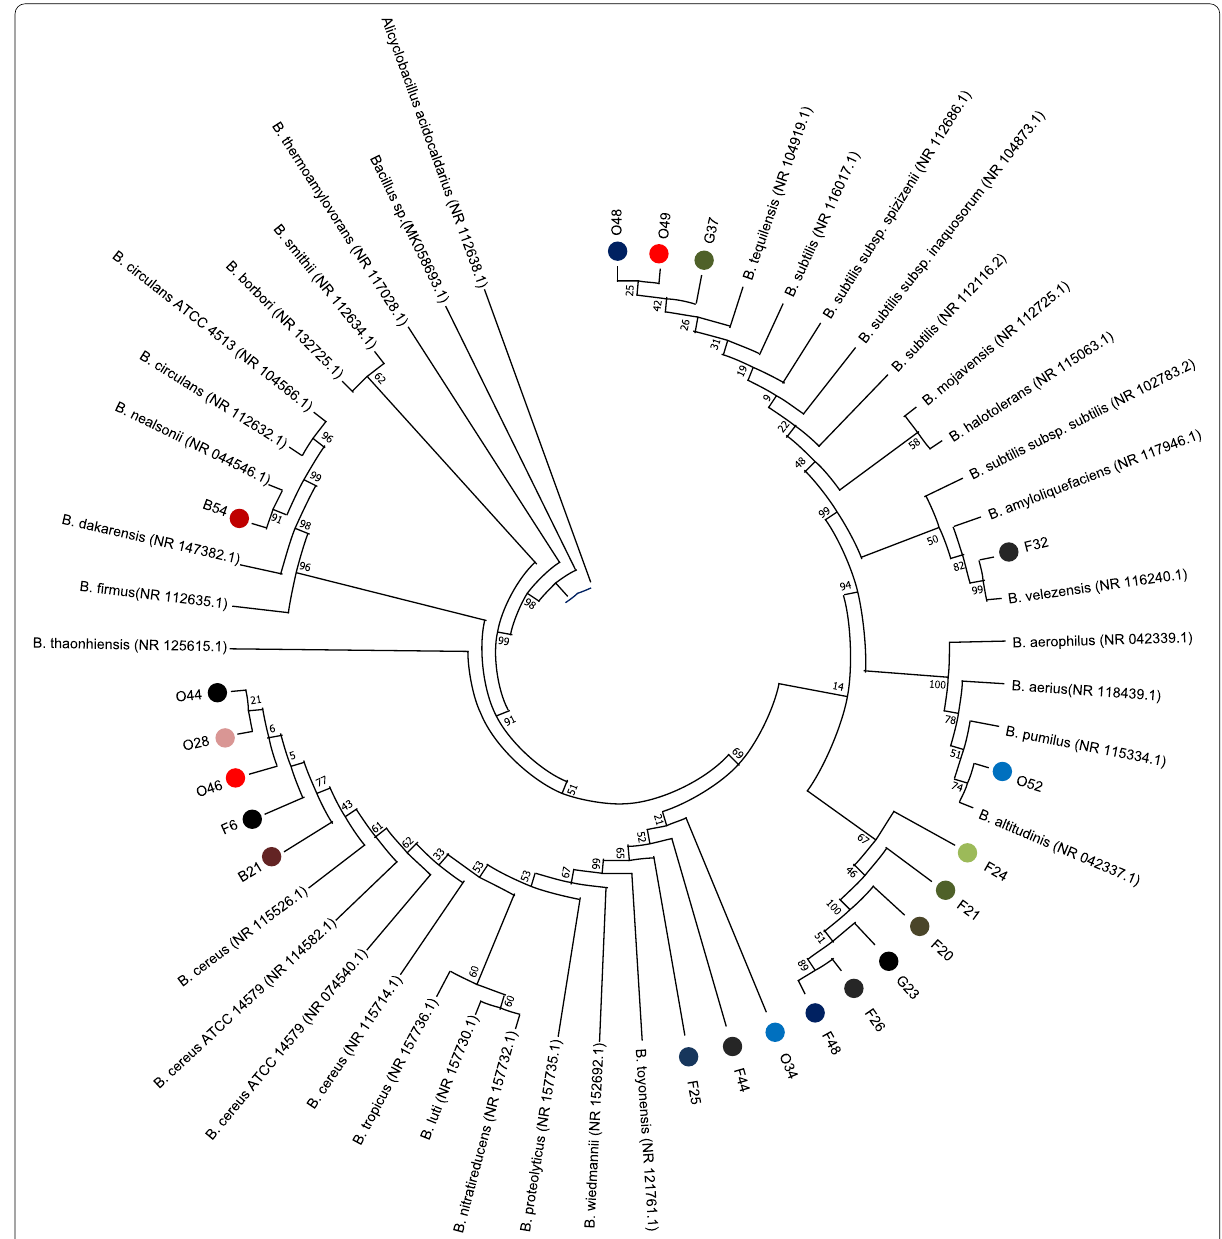
Fig. 2 Phylogenetic tree of Bacillus strains based on 16S rRNA constructed by neighbor joined method with Alicyclobacillus acidocaldarius as outgroup. Legend: B. Bacillus. The bootstrap consensus tree inferred from 1000 replicates is taken to represent the evolutionary history of the taxa = analyzed. Numbers next to the branches are the percentage of replicate trees in which the associated taxa clustered together in the bootstrap test (1000 replicates). This analysis involved 55 nucleotide sequences. All ambiguous positions were removed for each sequence pair (pairwise deletion